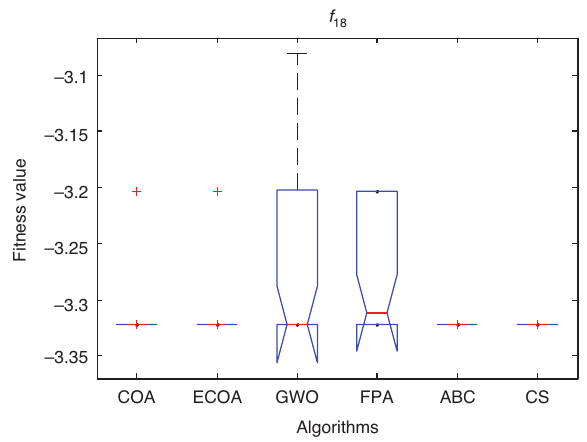
Figure 36: D = 6, ANOVA Test of Global Minimum for f